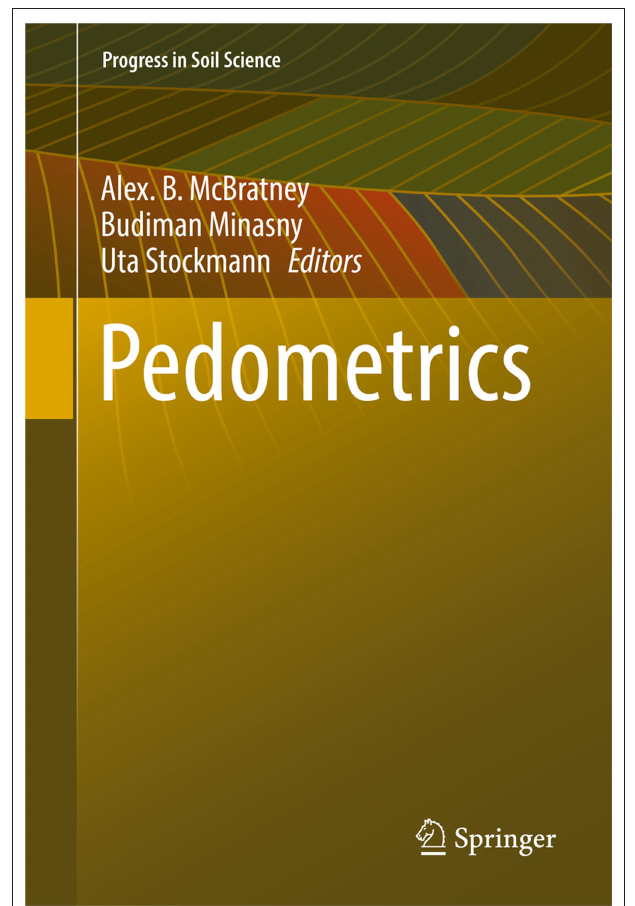
FIGURE 1 | Book cover of Pedometrics (Copyright @ 2018 Springer International Publishing AG, Cham, Switzerland. Reprinted with